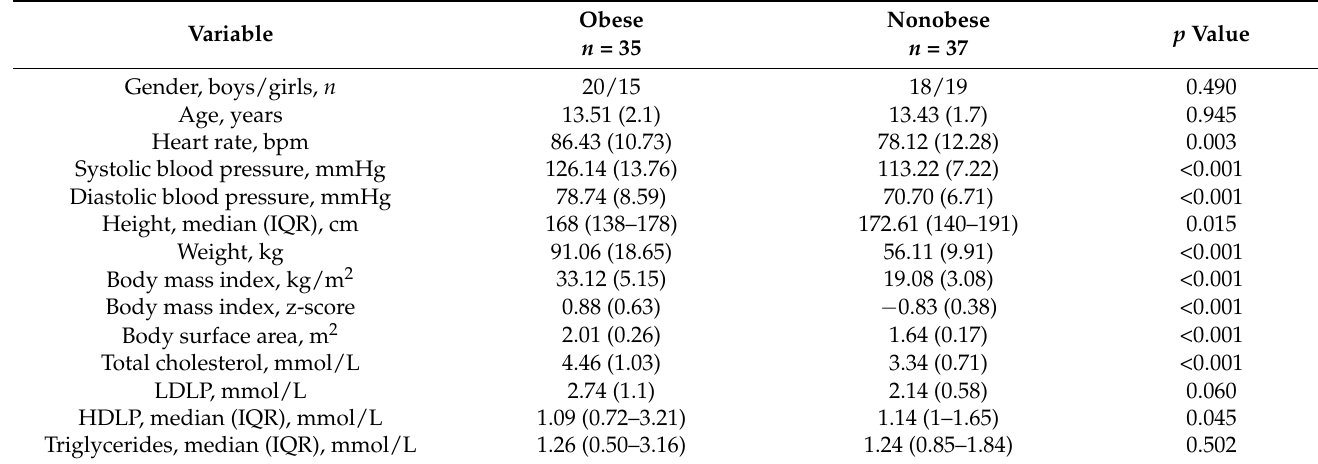
Table 1. Clinical characteristics.